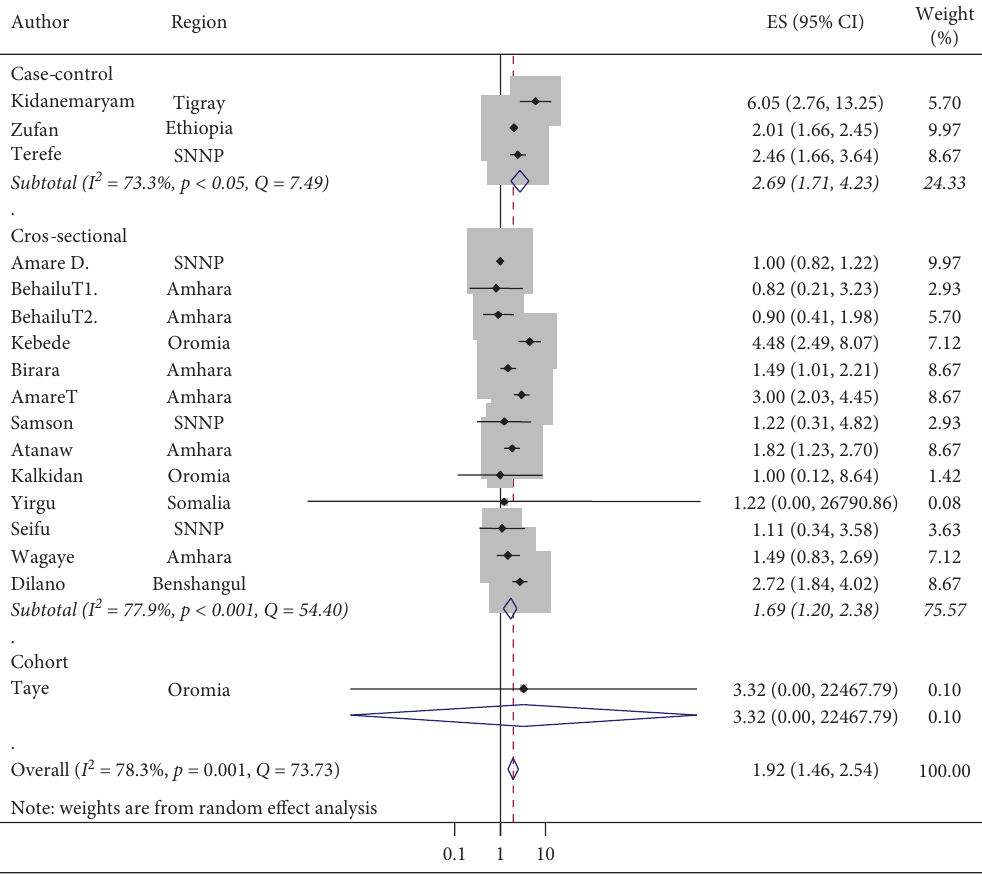
Figure 9: Subgroup analysis (by design) on the association of poor household wealth index and stunting and its 95% CI in Ethiopia,